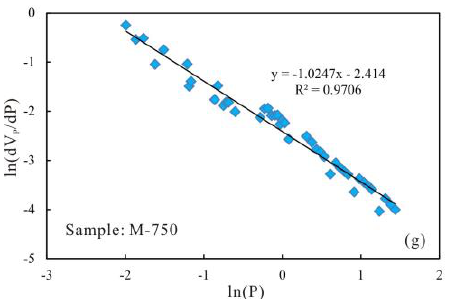
Figure 12. Fractal calculation results with ln(d V P / d P ) vs. ln( P ) obtained by mercury intrusion: ( a ) The initial sample M-0, ( b ) sample M-500, ( c ) sample M-550, ( d ) sample M-600, ( e ) sample M-650, ( f ) sample M-700, ( g ) sample M-750.